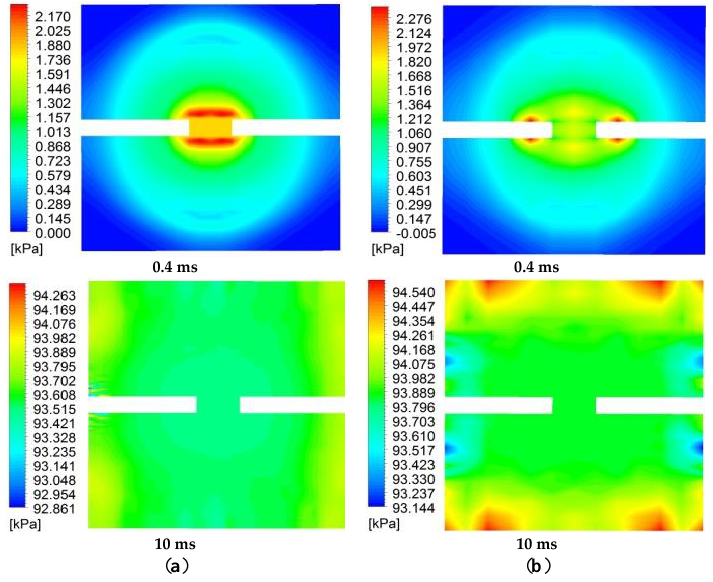
Figure 6. Pressure distribution at different time. ( a ) D = 1 cm; ( b ) D = 2 cm.